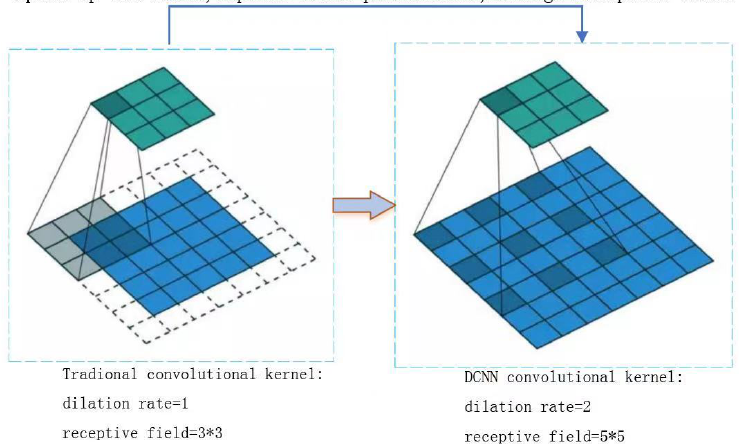
Figure 1. The diagram of the dilated